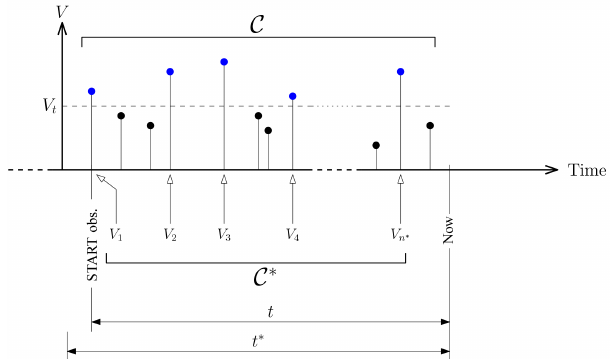
Figure 2. Sketch of the catalogues of events C and C ∗ . The events with volume V (e) larger than the threshold volume V t are indicated with blue bullets, those smaller than the threshold volume V t are indicated with black